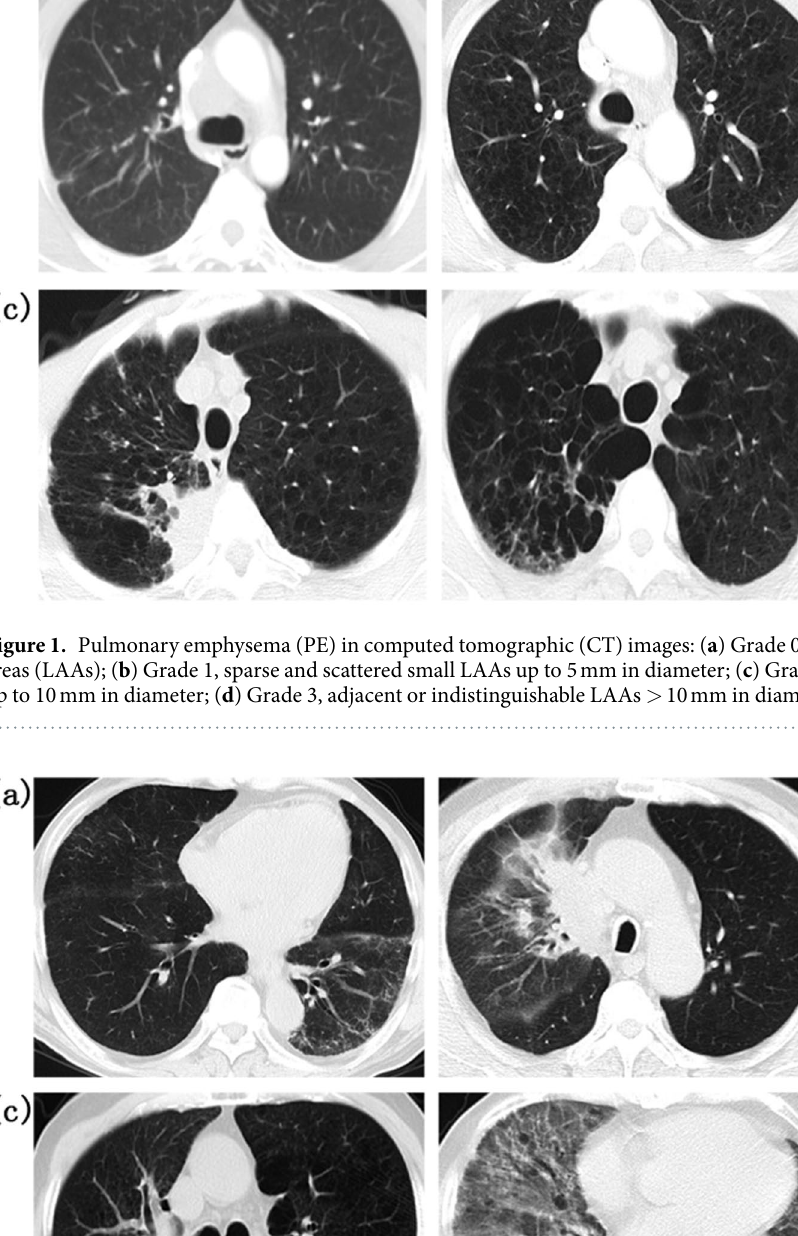
respectively. Multivariate logistic regression analyses were performed to evaluate the data for the association between clinical factors and DVH parameters with RP. Statistical analyses were performed using SPSS software 13.0. A P -value < 0.05 was considered significant.